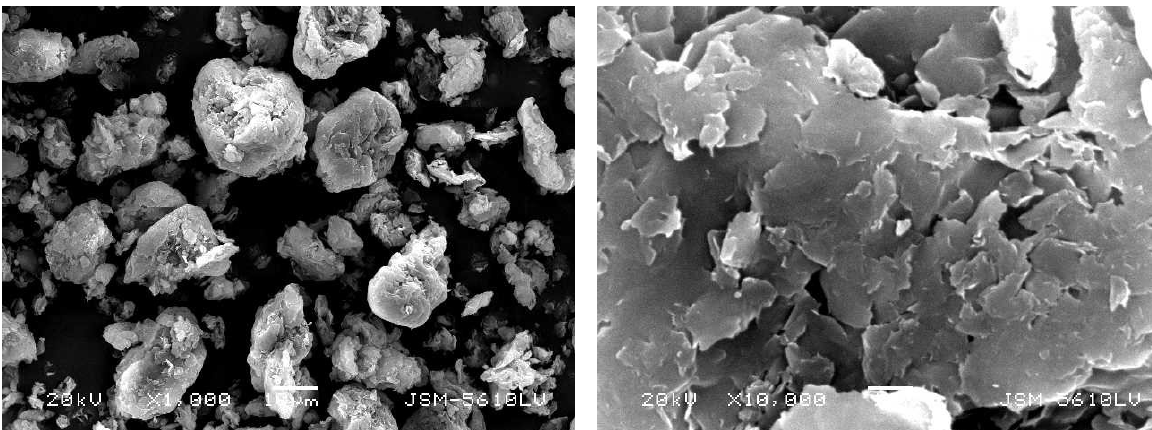
Figure 2: SEM micrographs of Na-MMT